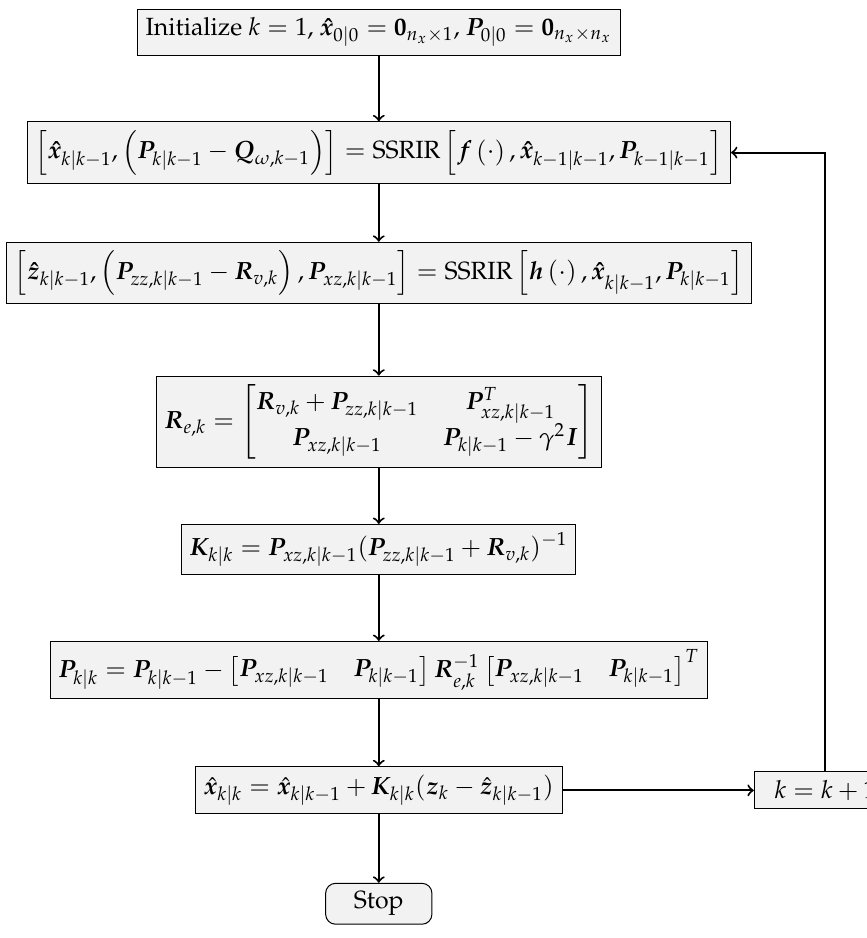
Figure 3. Flowchart of the SIH ∞ F